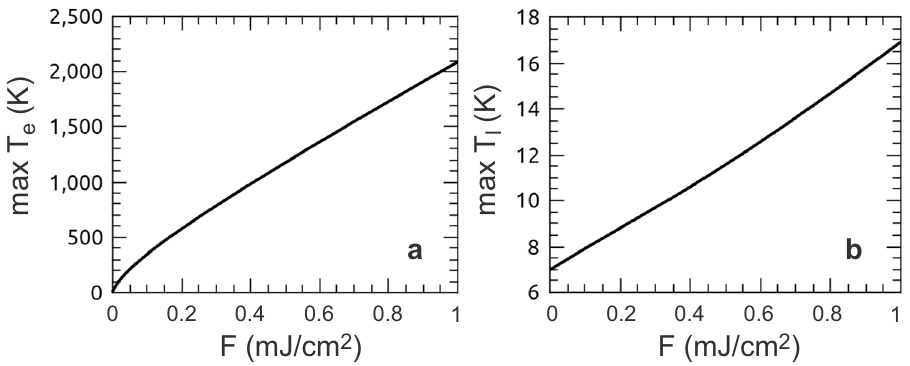
Figure 7. Fluence dependence of maximum temperatures reached in Ag for a 72 fs pulse at an adsorbed fluence of 1 mJ/cm 2 : ( a ) electron temperature T e ( b ) phonon temperature T l